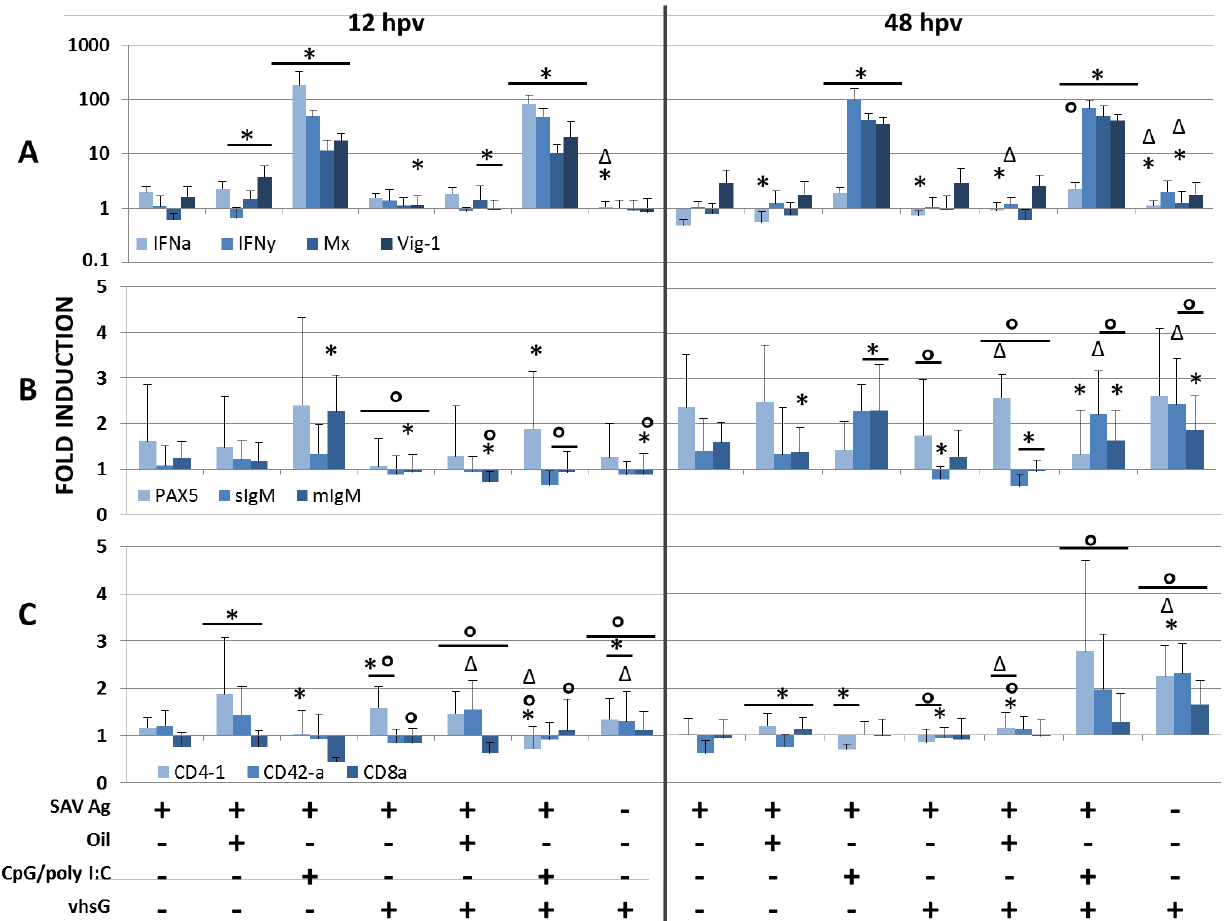
Figure 2. Relative expression of ( A ) antiviral, ( B ) B- and ( C ) T-cell markers in spleen at 12 and 48 hpv for all treatments compared to saline-treated fish (expression is normalized to reference gene EF1aB). Relative expression is presented as histograms (the colour codes for each gene analysed are indicated below the histograms) calculated from fold induction by Pfaffl’s method (see Materials and Methods), and significant up- or down-regulation is based on data from REST 2009. Significant differences for all treatments compared to SAV Ag are highlighted with an *, against SAV Ag vhsG as Δ and against SAV Ag CpG/polyI:C as °, + or –, respectively, indicates the presence or absence of either SAV Ag, oil, CpG/polyI:C or